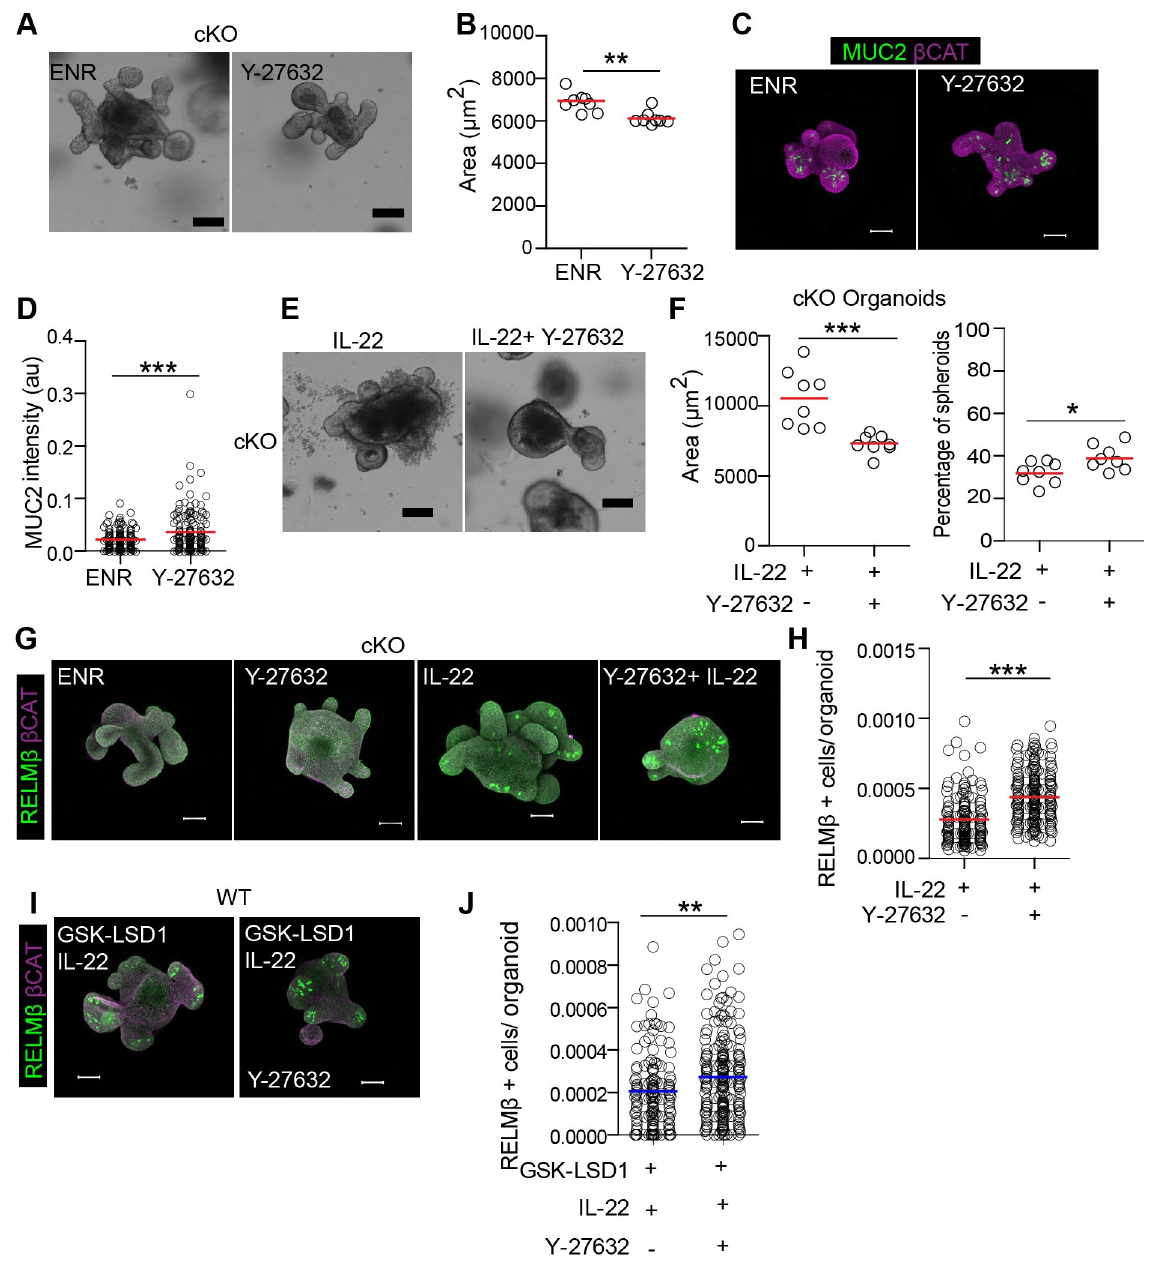
Fig 7. Cytoskeleton manipulation partially rescues goblet cell maturation in LSD1-deficient organoids. (A) cKO organoids were left untreated (ENR) or treated with Y-27632 (10 μ M) for 4 days. Representative bright field images are shown. Scale bar is 100 μ m. (B) Quantification of organoid area from minimal projections 4 days after seeding. Dots represents mean of one well, pooled from 3 independent experiments. (C&D) Representative immunofluorescent images of MUC2 (green) and β -catenin (purple). MUC2 fluorescence intensity relative to organoid area was measured. Scale bar is 50 μ m. (E) cKO organoids were treated with IL-22 (5ng/ml) or IL22+ Y-27632) for 4 days. Representative bright field images are shown. Scale bar is 100 μ m. (F) Mean organoid area of cKO organoids is depicted as well as the percentage of spheroids in each well 4 days after seeding. (G) cKO organoids were left untreated (ENR) or treated with IL-22 (5ng/ml), Y- 27632 (10 μ M) and combination of Y-27632 and IL-22 for 4 days and representative images for RELM β (green) and β -catenin (purple)staining are shown. (H) Pooled quantification of RELM β + cells per organoid area from independent experiments. (I) WT organoids were pre-treated with GSK-LSD1 for 7 days. Next, these organoids were treated with combination of IL-22 (5ng/ml) + GSK-LSD1 and GSK-LSD1+ IL-22+ Y- 27632 for 4 days. Immunofluorescence images of RELM β (green) and β -catenin (purple) are shown. (J) Quantification of RELM β + cells per organoid area is shown. Unpaired two-tailed Student’s t test (B, D, F, H & J) was performed to define significance. � P � 0.05, �� , P < 0.01, ��� P �